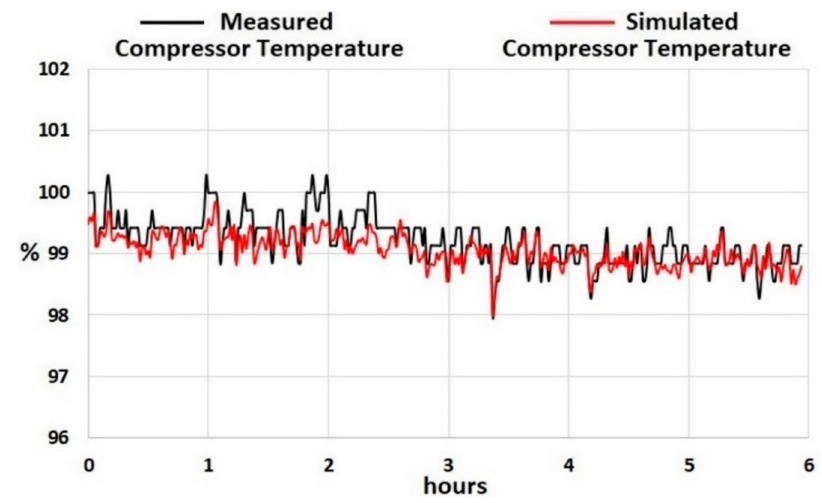
Figure 34. Measured and simulated compressor discharge temperatures at low IGV offset.